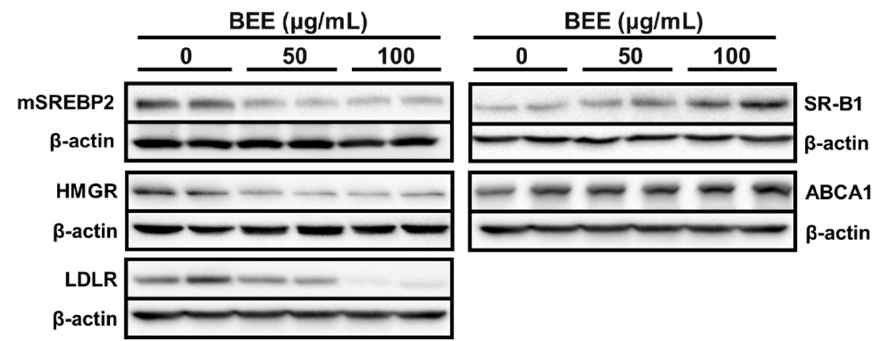
Figure 2. The proteins for cholesterol biosynthesis and absorption in BEE-treated HepG2 cells. The cells were treated with 50 or 100 μ g/mL of BEE for 24 h. The representative image of the Western blot from two different experiments is shown. β -actin was used as a loading control.